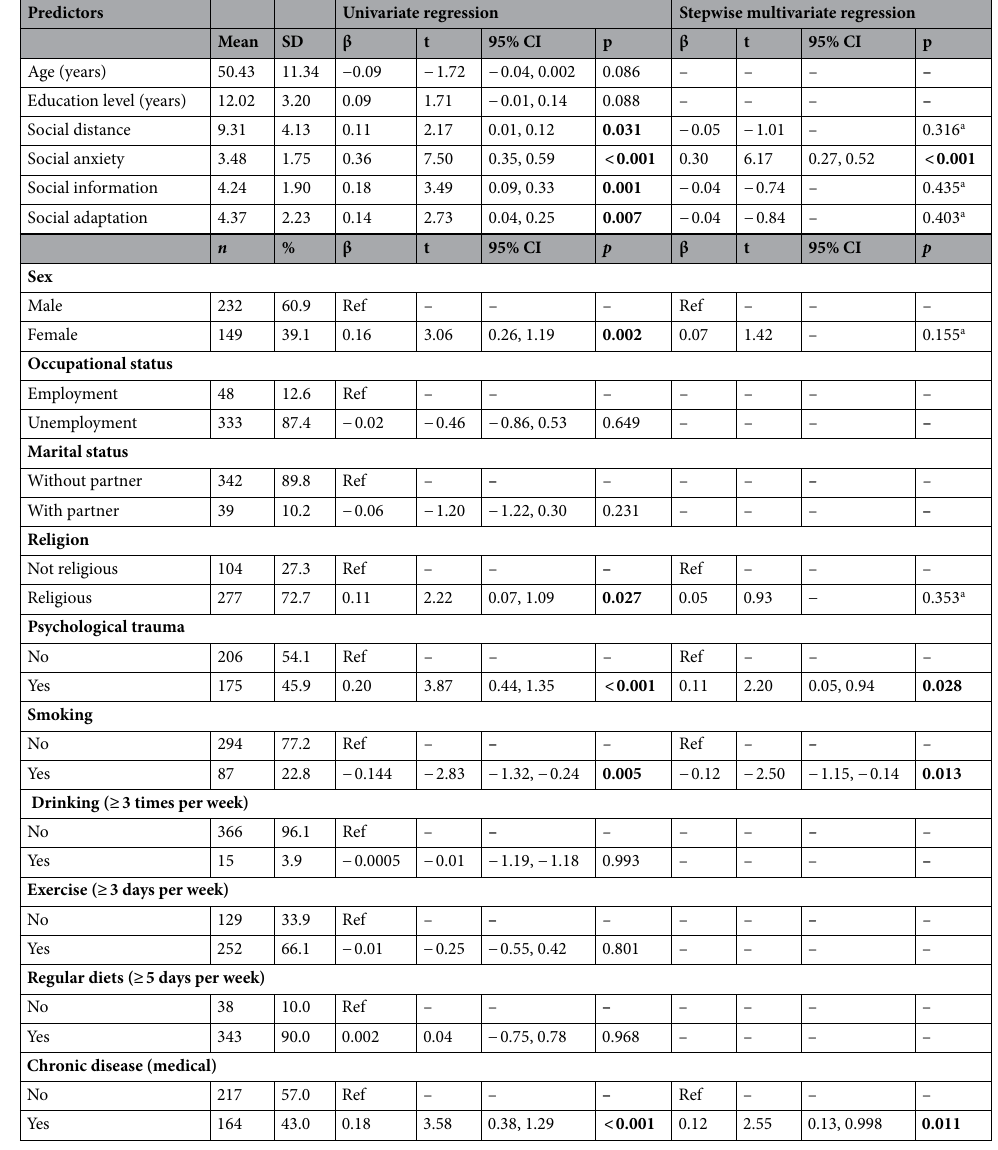
Table 1. Predictors for level of sleep disturbance examined by univariate and stepwise multivariate linear regression (N = 381). β: standardized coefficients; t: T score; CI: Confidence interval; SD: Standard deviation; Bolds: p < 0.005; a : excluded from stepwise